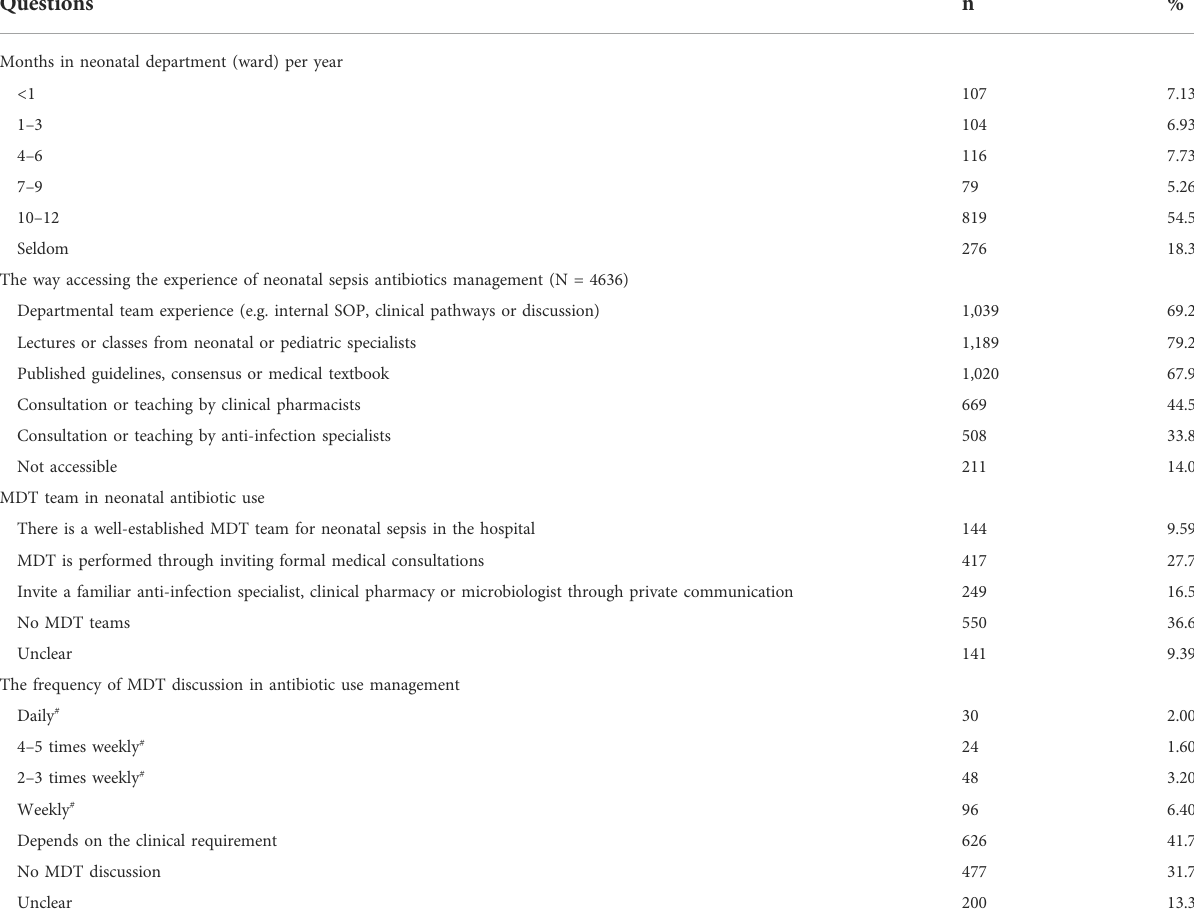
TABLE 2 Experience in neonatal sepsis